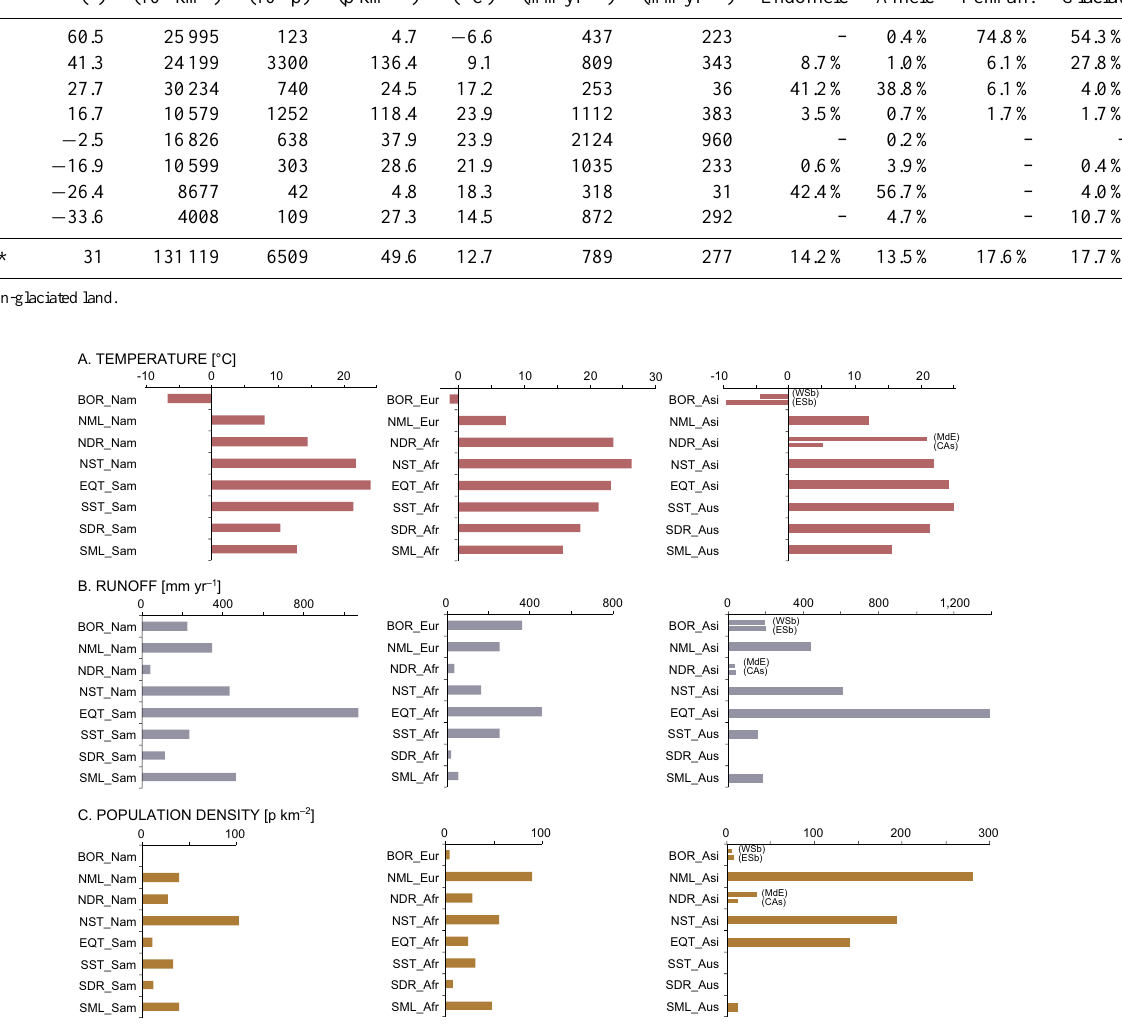
Fig. 4. North to south distributions for the 26 individual hydroregions on each continent along three north–south profiles: (1) North Amer- ica (NAm) and South America (SAm), (2) Europe (Eur) and Africa (Afr), (3) Asia (Asi) and Australia (Aus). (a) : average temperature; (b) : run-off; and (c) : population density. BOR=boreal, NML=northern mid-latitude, NDR=northern dry, NST=northern subtropical, EQT=equatorial belts and SML, SDR, SST their southern analogues (see Fig. 2 for their spatial